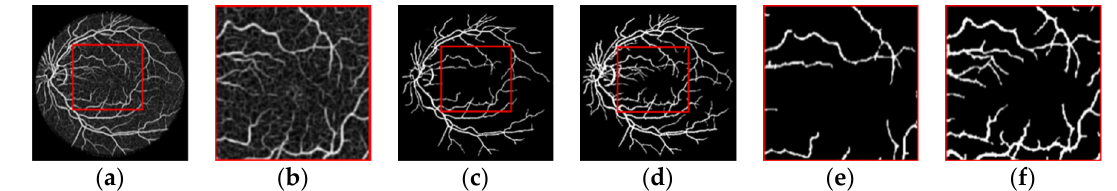
Figure 5. Comparison of multi-threshold and single-threshold segmentation results. ( a ) Multi-scale matched filtering figure; ( b ) Detail amplification of Multi-scale matched filtering; ( c ) Single-threshold segmentation figure; ( d ) Three-threshold segmentation figure; ( e ) Detail amplification of Single-threshold segmentation; ( f ) Detail amplification of Three-threshold segmentation. Table 2. OTSU-PSO algorithm.